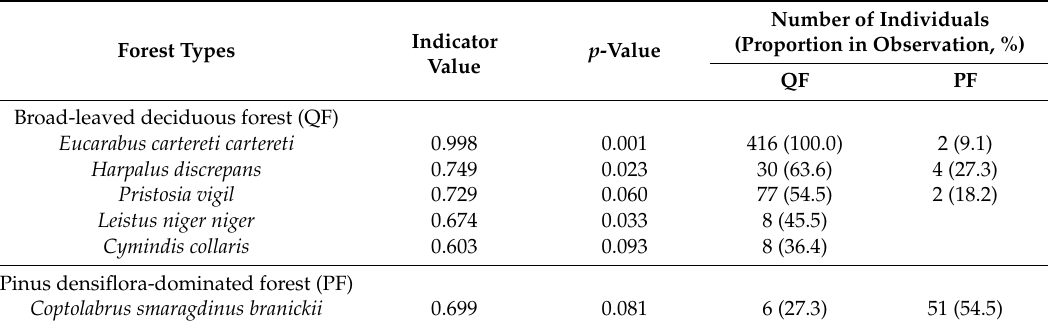
Table 4. Two-way indicator table showing carabid beetle species indicator value for habitat clustering hierarchy according to forest type, the number of individuals of ground beetle species by forest types, and their proportion in observation (%). Carabid species that showed high indicator value ( p < 0.1) were